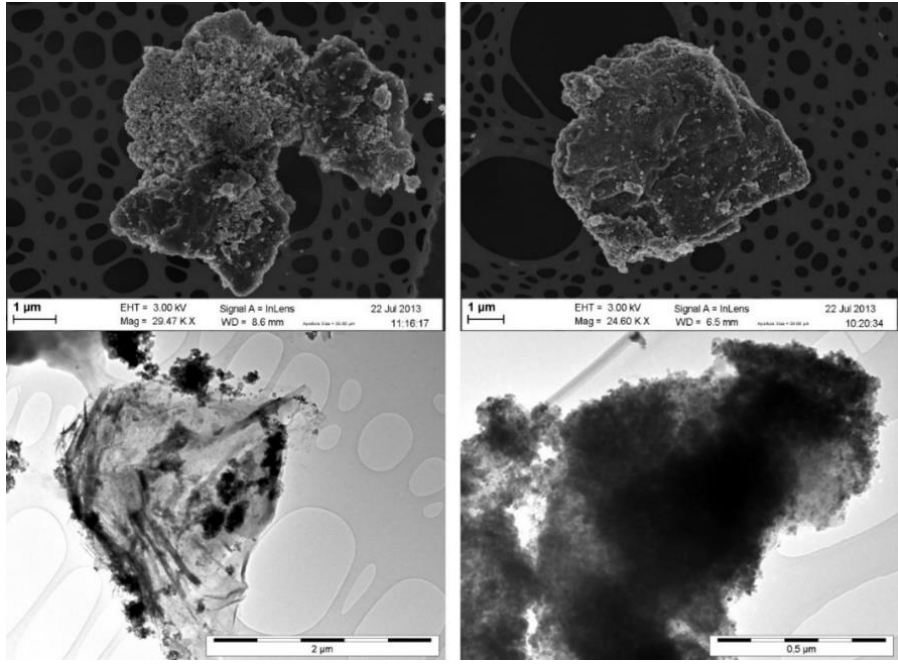
Figure 5. SEM ( top ) and TEM ( bottom ) images of the GO-supported magnetite Fe 3 O 4 nanocomposites obtained by direct co-precipitation ( left ) and solvothermolysis ( right ) [16], evidencing the differences in distribution of the magnetite NPs over the graphenic surface. Appl. Sci. 2019 , 9 , x FOR PEER REVIEW